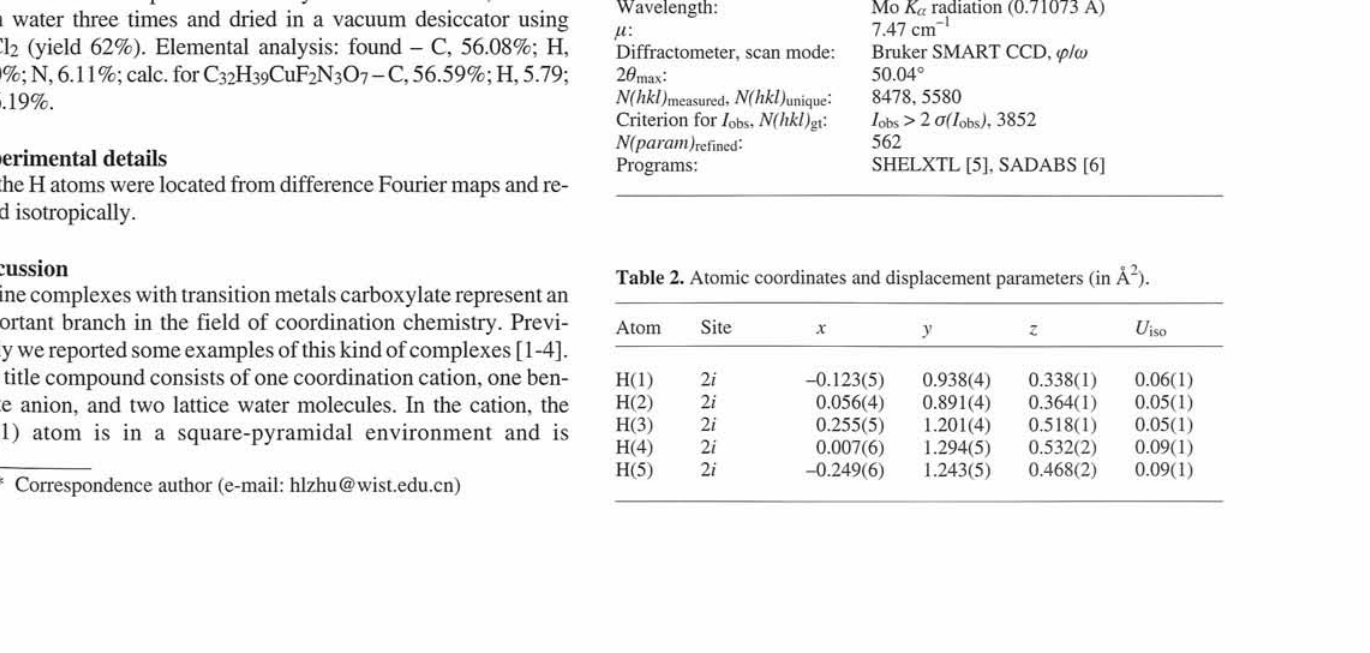
Table 2. Atomic coordinates and displacement parameters (in Â